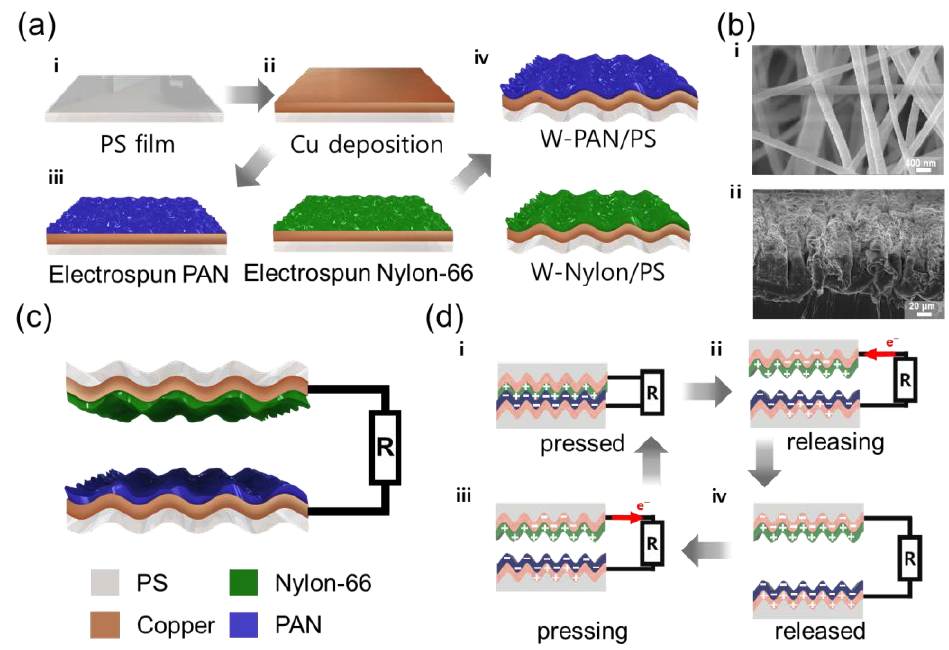
Figure 1. ( a ) Fabrication of W-PAN/PS and W-Nylon/PS electrode. ( b ) Field emission scanning electron microscope (FE-SEM) image of W-PAN/PS. ( c ) Schematic diagram of wrinkled TENG (W-TENG). ( d ) Schematic diagram of the electricity-generation process of W-TENG.